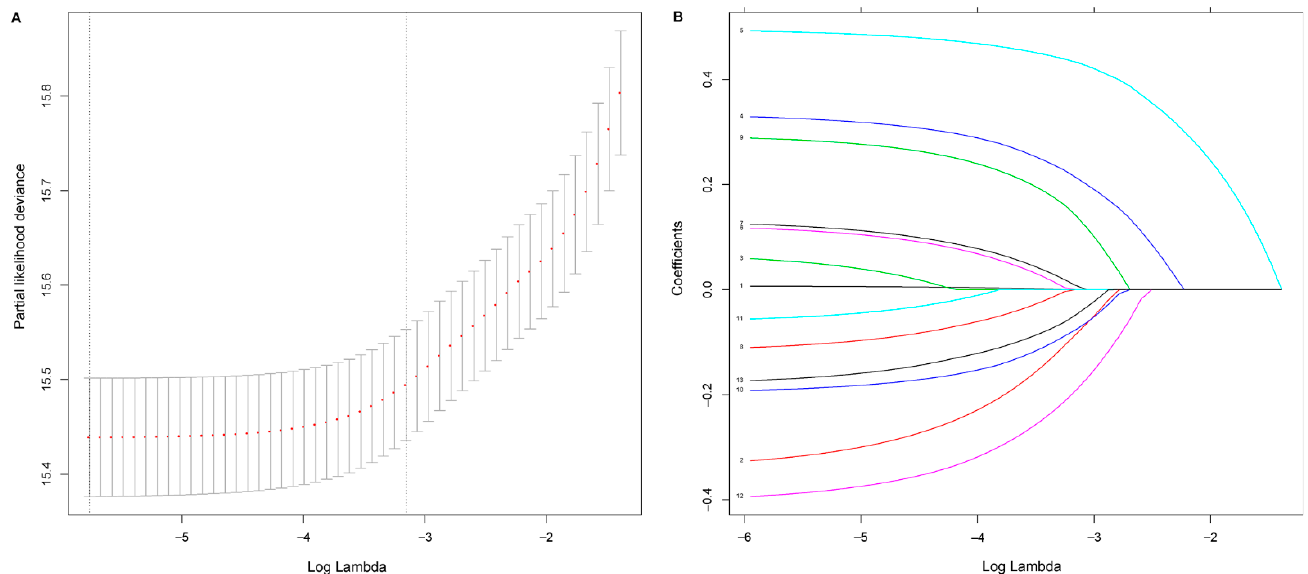
Figure 1. Selection of prognostic factors using least absolute shrinkage and selection operator (LASSO) Cox regression. ( A ) Tuning parameter λ based on minimum criteria in the LASSO regression. The partial likelihood binomial deviance is plotted against log λ . Using the minimum criteria and the one standard error of the minimum criteria, dotted vertical lines are set at the optimal values log λ , where factors are selected. ( B ) For clinicopathological features, LASSO coefficient profiles are plotted vs. log λ sequences. The dotted vertical line shows the nonzero coefficients, where eight nonzero coefficients are included.